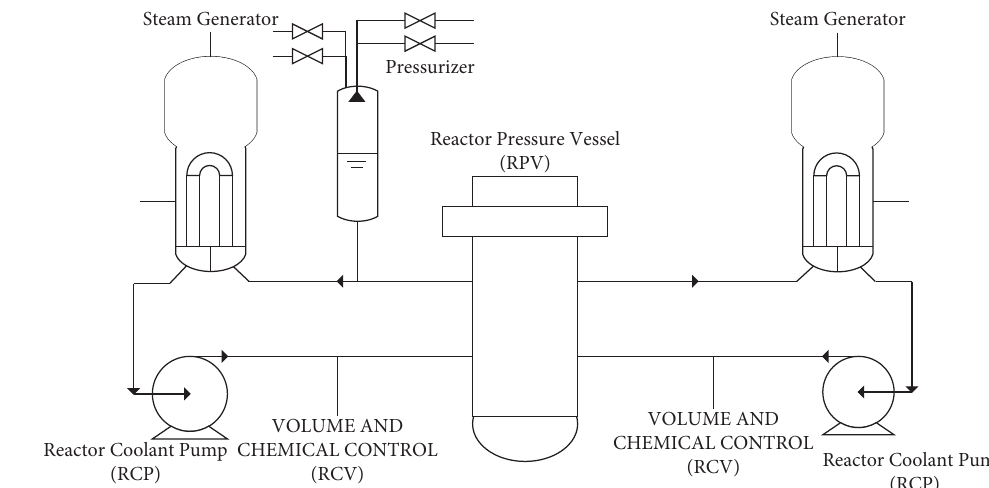
Figure 2: Te primary coolant system (PCS) of the reference nuclear power